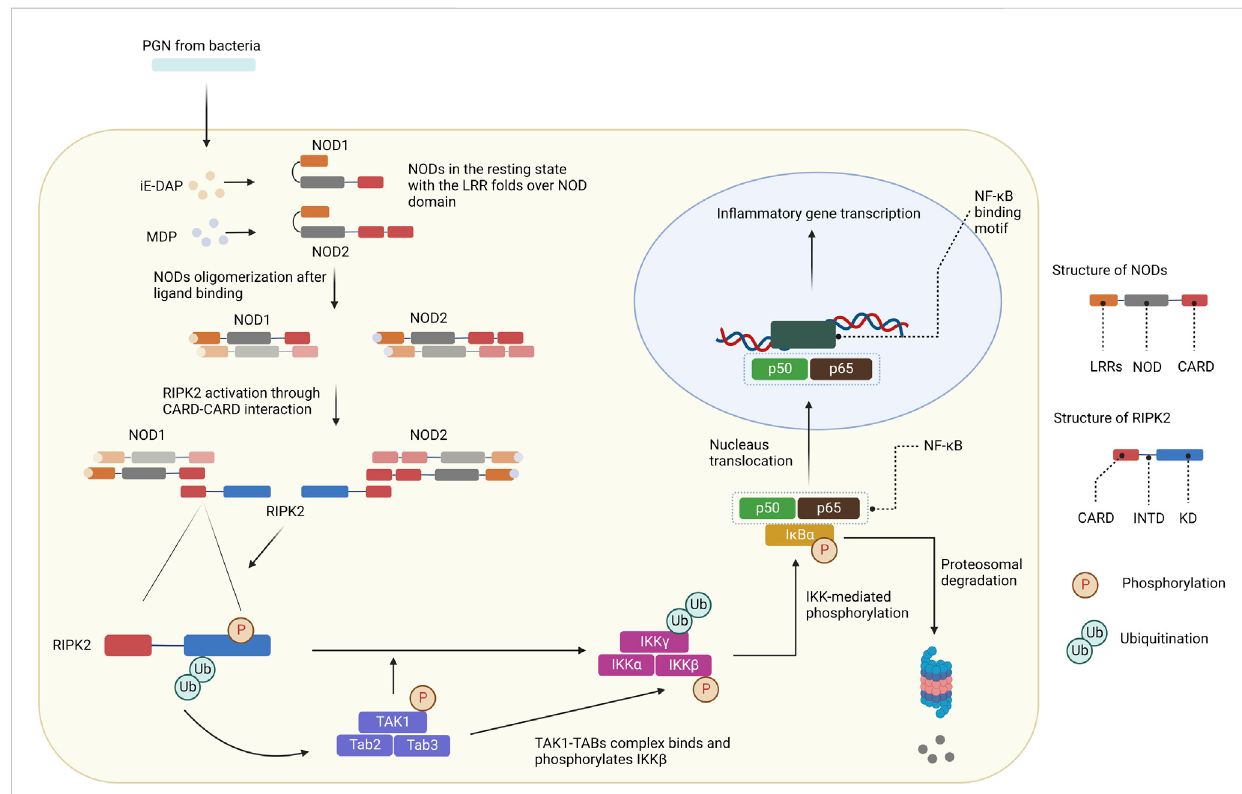
FIGURE 3 NODs/RIPK2 signaling pathways. After ligand binding, NODs oligomerize and form signaling complexes with RIPK2. RIPK2 is activated by auto- phosphorylation and further polyubiquitinated by E3 ligases. Ubiquitinated-RIPK2 turns on TAK1. pUb of both RIPK2 and IKK γ allows the TAK1-TABs complextobindandphosphorylateIKK β .IKK-mediatedphosphorylationoftheNF- κ BinhibitorI κ B α leadstoitspUbandsubsequentdegradationthrough the UPS. Free NF- κ B translocates to the nucleus and promotes the expression of downstream target genes for in fl ammatory cytokines and